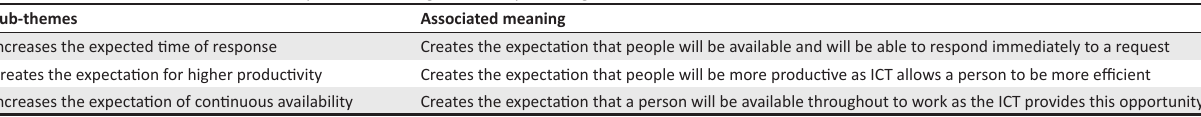
TABLE 4: Theme 4: New and additional expectations brought about by ICT usage.